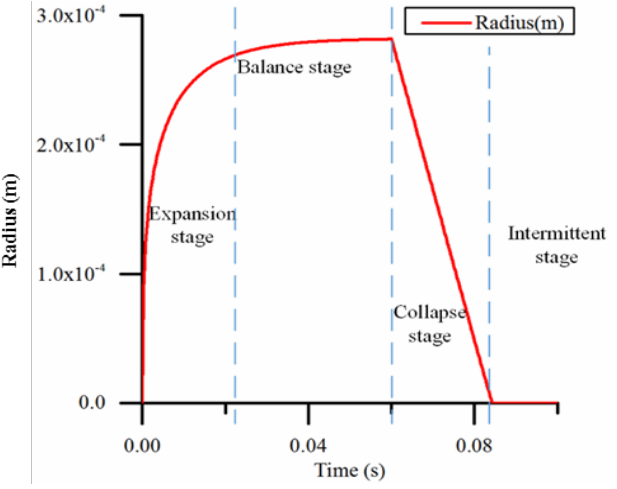
Figure 9. A typical result of the bubble radius during one cycle with adequate time.